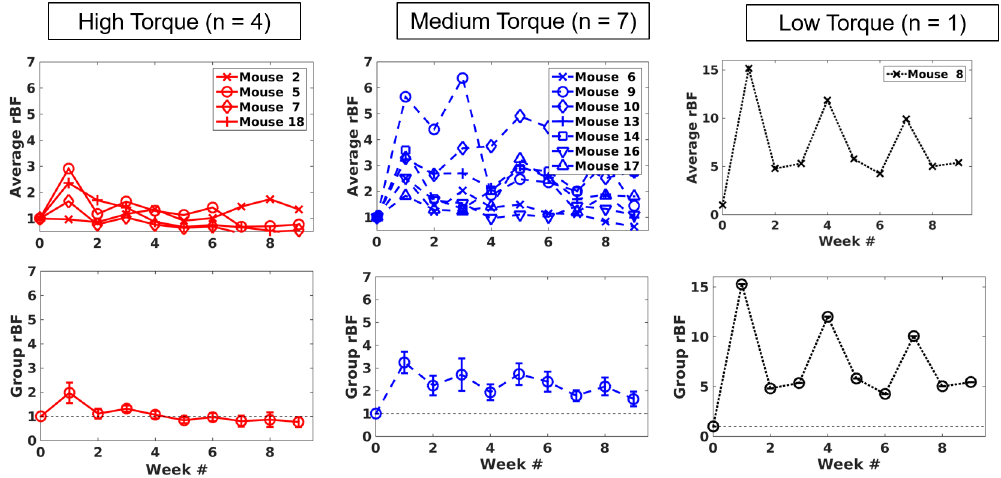
Fig 6. Average blood flow in the graft region ( rBF g ) during the 9 weeks of healing based on the measured maximum torque. The range of maximum torque for the high, medium, and low torque groups are > 10, 5–10, and < 5 N (cid:1) mm, respectively. The first row shows individual changes and the second row shows corresponding group averages. Note the y range for the low torque group is much larger than the others.